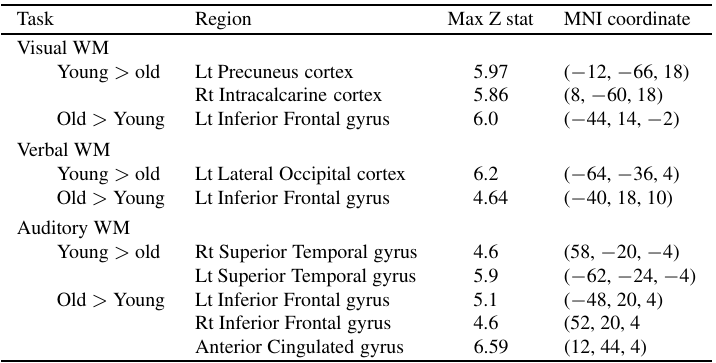
Table 3 Age-related activations in each